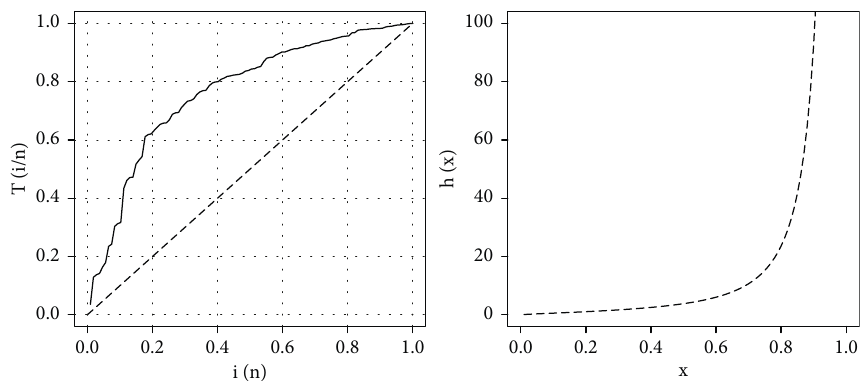
Figure 10: TTT plot and fitted HRF of ExRK model for the milk data